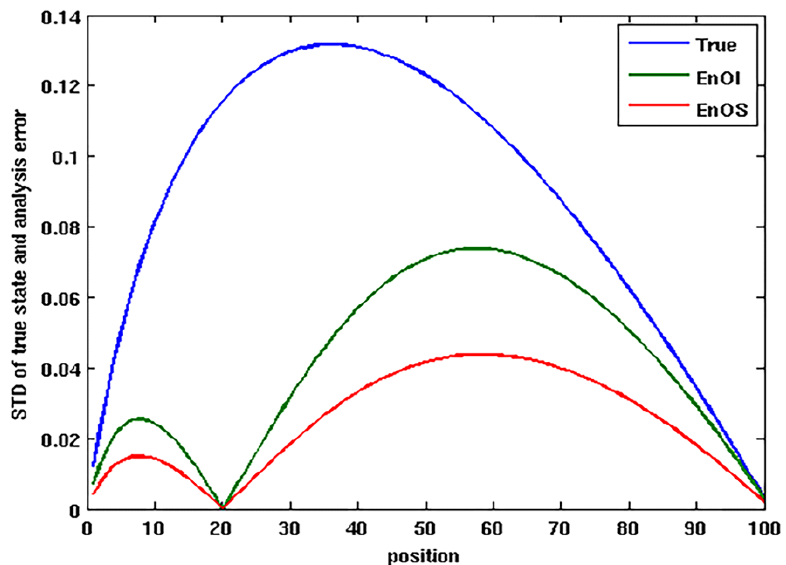
Figure 2. Standard deviations of stream function predicted by the forced Rossby wave model. The horizontal axis shows the zonal position scaled by the width of the ocean ( x / L ) and the vertical axis shows the standard deviation of the time-varying stream function for each grid point. Blue line: standard deviation of stream function resulting from white noise forcing. Green line: standard deviation of analysis errors resulting from assimilation of perfect observations at x / L = 0.2 using EnOI and no forcing. Red line: as for the green line, but for observations assimilated using EnOS with lags of 0 and 1 time